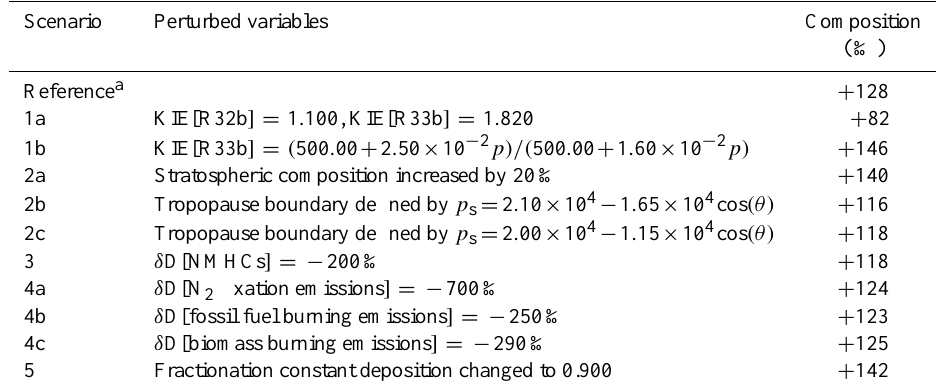
Table 3. Sensitivity of isotopic composition of H 2 on changes in parameters of the isotope scheme. Scenario Perturbed variables Composition